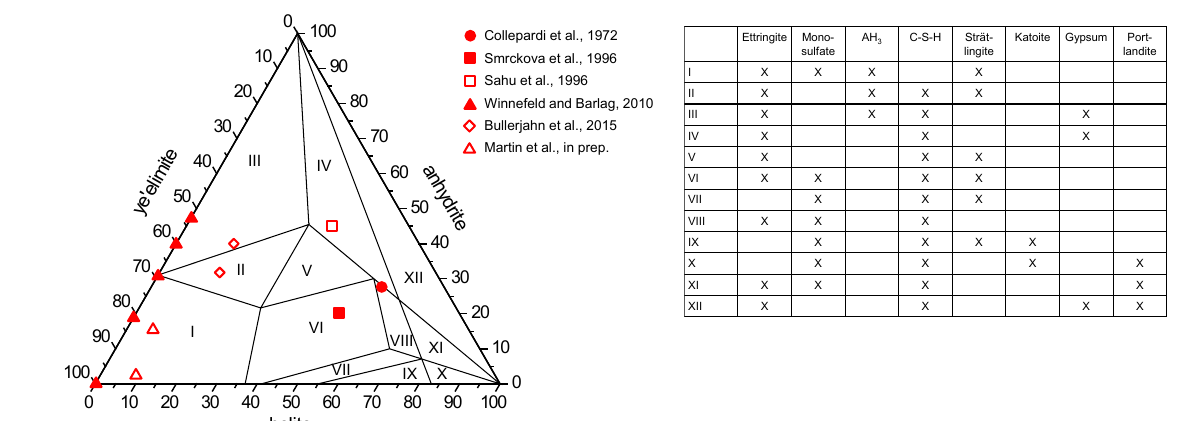
- C 2 S - CS - H 2 O. The symbols mark experimental data from selected literature references � �